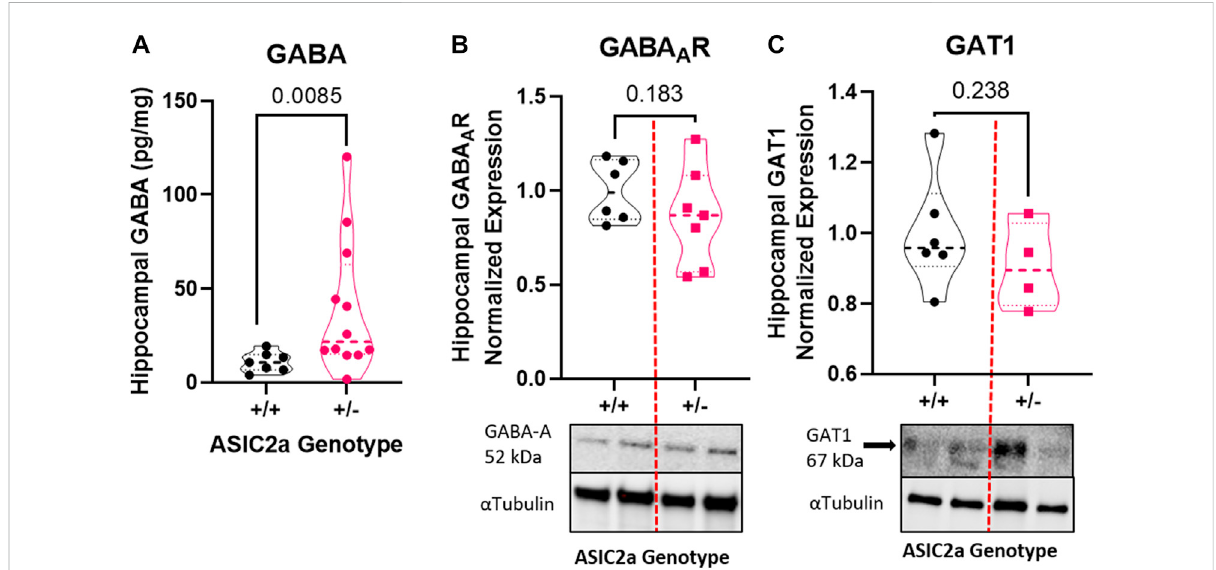
FIGURE 3 Changes in inhibitory neurotransmitter-related proteins in hippocampal synaptosomes following seizures in pregnant mice with reduced ASIC2a. (A) Increased hippocampal synaptosome levels of GABA ( n = 7 or 14 mice per genotype), and no difference in (B) GABA A R, and (C) GAT1 protein expression following seizures in pregnant ASIC2a heterozygous mice. GABA — γ -Aminobutyric acid, GAT1 — GABA transporter 1. N = four to seven miceper genotype.Individualdata points aredisplayed.Thick dashedline isthemedian and thethindashed linesare thequartiles Signi fi cance was calculated using Mann-Whitney U test.